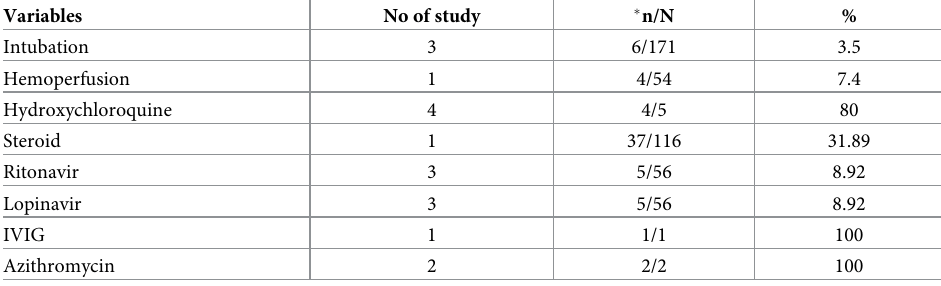
Table 4. Treatment modalities in the included